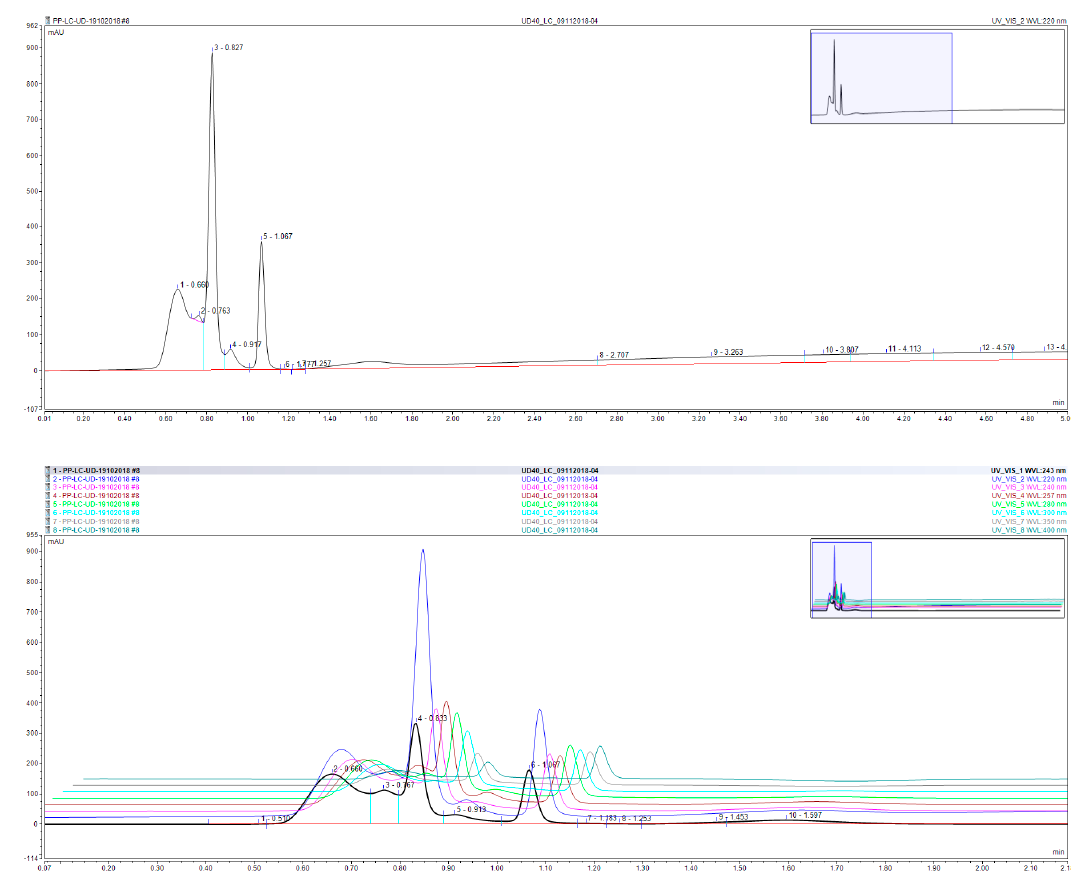
Figure 9. UPLC chromatogram (top) and 3D chromatogram (bottom) of UD leaf aqueous extract representing absorbance (y-axis) as a function of time (x-axis). The 3D chromatogram is reported at wavelengths 220 (blue), 240 (pink), 243 (black), 257 (brown), 280 (green), 300 (cyan), 350 (grey), and 400 (navy green) nm.